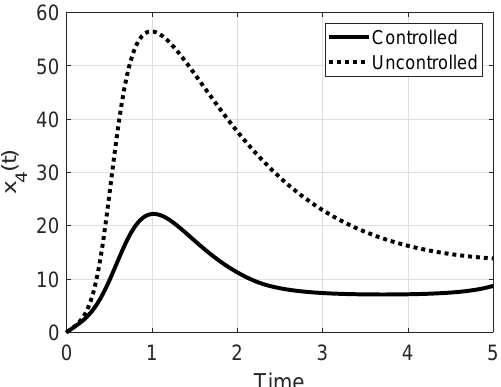
Figure 15. Case 5: evolution of the number of x 4 ( t ) with (continuous line) and without control (dotted line).